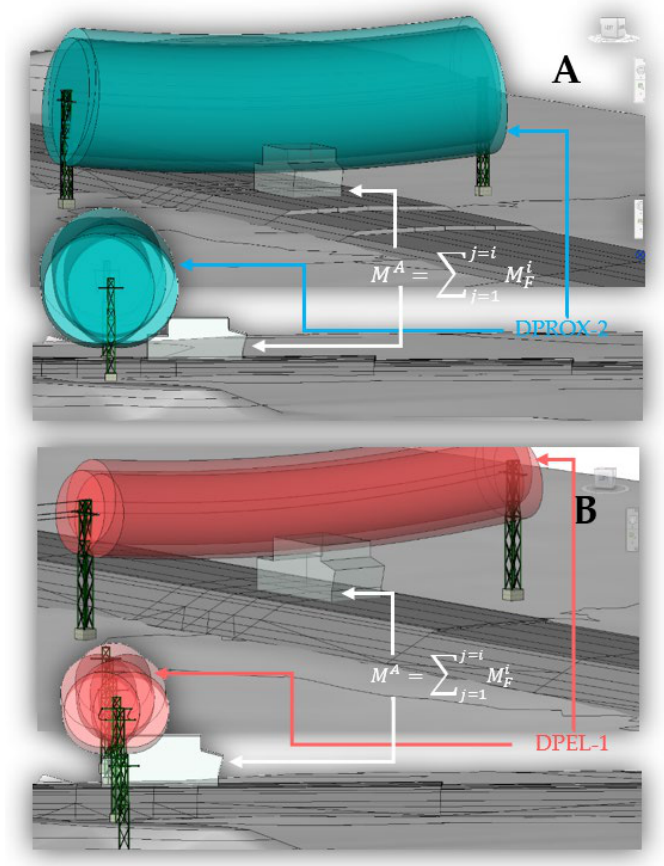
Figure 3. 3D view and longitudinal view of the 4D simulation in Revit. ( A ) Paving phase with collision analysis with cable proximity zone 2. ( B ) Bituminous mix paving phase with collision analysis with cable danger zone 1.